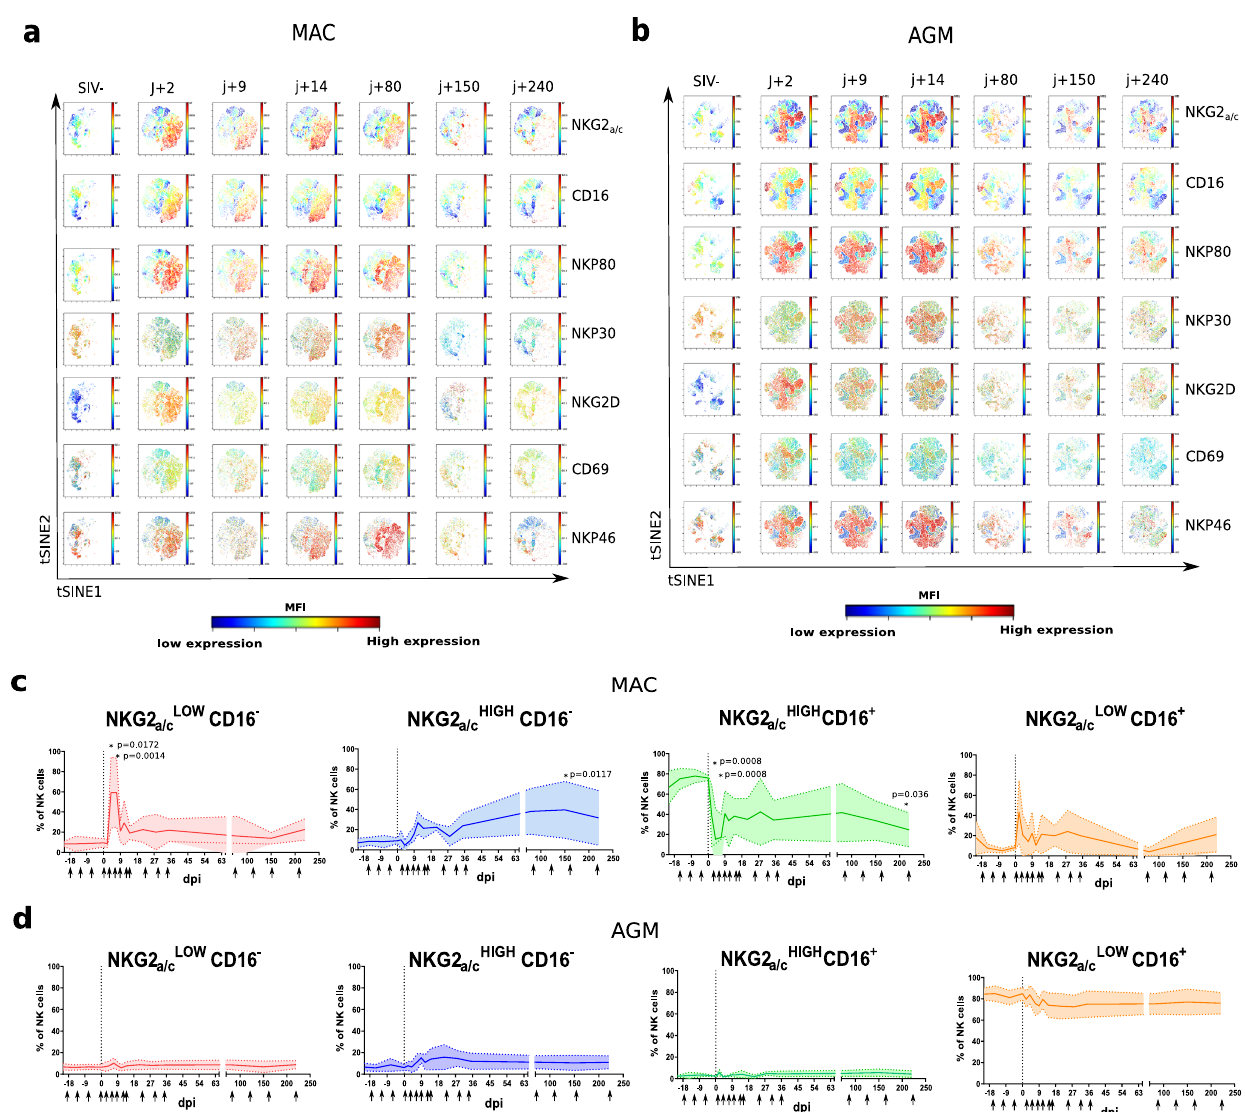
Fig. 1 Longitudinal follow up of blood NK cells during SIV infection in the natural and heterologous hosts. Six cynomolgus macaques (MAC) and six African Green Monkeys (AGM) were followed before and after SIV infection (acute and chronic infection up to day 250 p.i.). a, b viSNE analysis (Cytobank) on the concatenated fl ow cytometry data of a six MAC and b six AGM. Cells were stained with 12 markers and measured by fl ow cytometry. viSNE analysis was run on 80000 live CD45 + CD3 - CD20 - CD14- single cells per sample using all surface markers. Data show expression on all viable single cells from blood, subjected to the tSNE algorithm, at the given time point. The red and blue colors indicate higher and lower mean fl uorescence intensity (MFI) of a given marker. c , d Frequency of NK cell subpopulations over time in blood from c six MAC and d six AGM. The arrows indicate the analyzed time points. The full line represents the median, and the interquartile range is indicated by the area between the dotted lines. The color code used to de fi ne each of the four subpopulations is the same throughout the manuscript as described in Supplementary Fig. 1. For group comparisons two-sided Wilcoxon signed-rank test with Bonferroni correction were used ( n = 13). P values of less or equal to 0.05 were considered statistically signi fi cant. Asterix indicate signi fi cant change when compare to the base line. Exact P value are provide on the